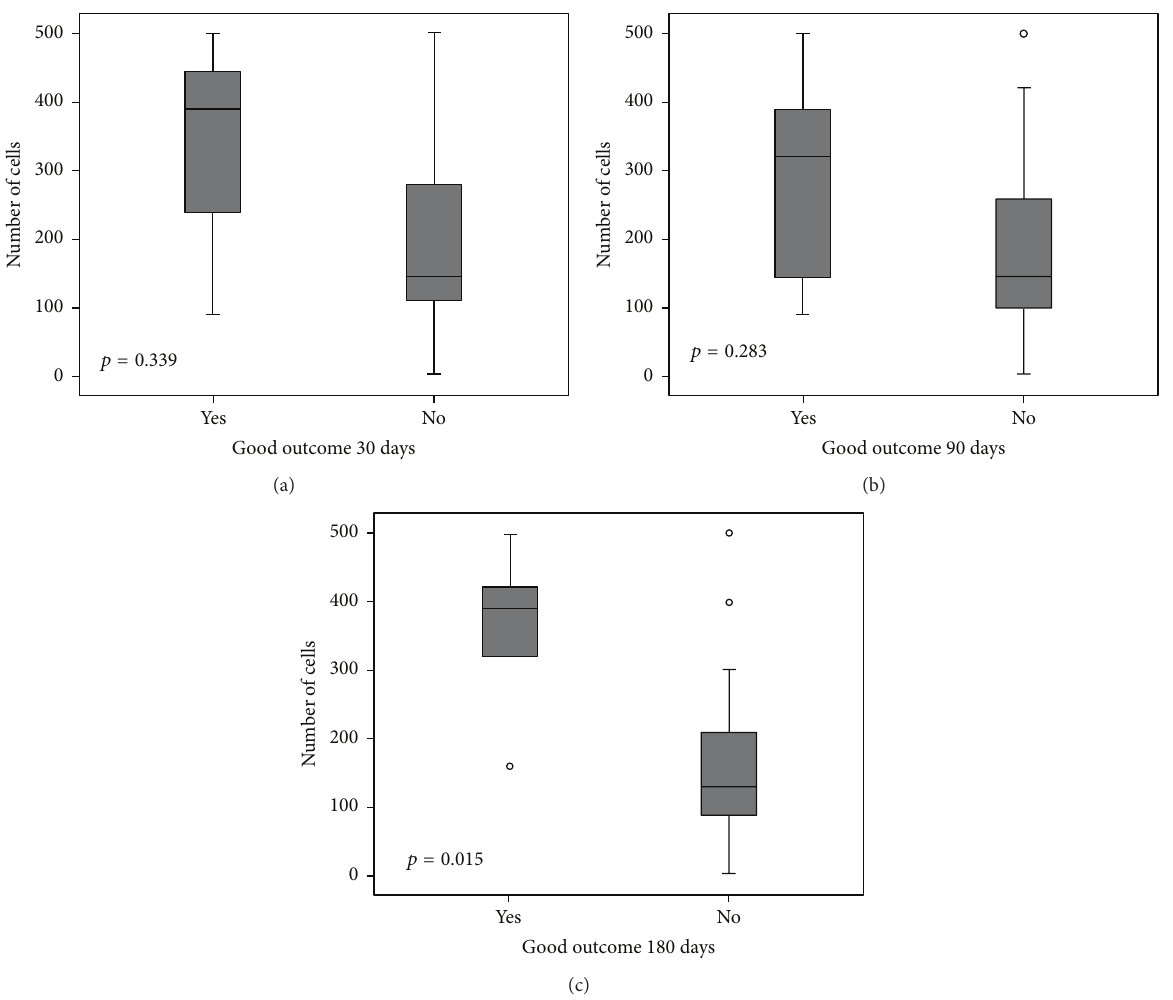
Figure 1: Box plot of the relation between number of injected cells and stroke outcomes during follow-up. Patients with good outcomes had no or mild disability (mRS of 0–2). Values are expressed in millions of cells. Small circles mean